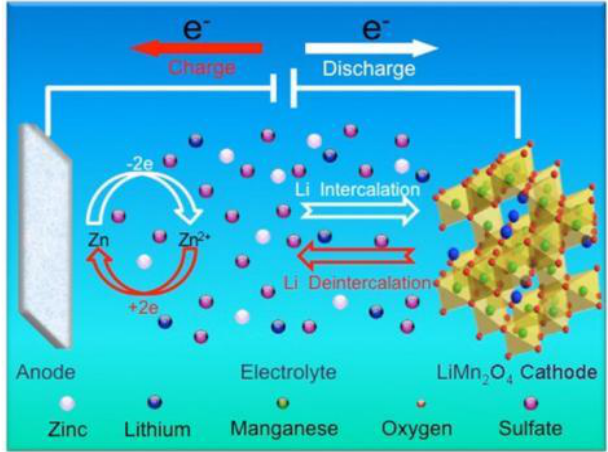
Figure 1. Schematic illustration of the mechanism for ReHAB operation (modified from Ref. [24] with permission from Elsevier). Table 1. Comparison of various types of major secondary aqueous batteries [1,3,5,16,24].